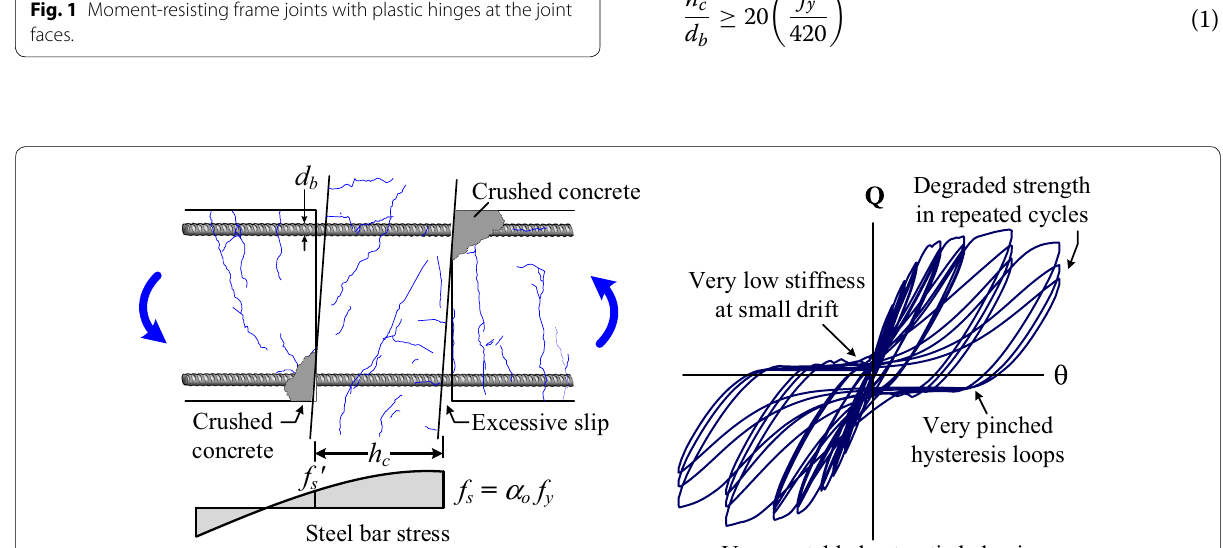
Fig. 2 Consequences of bond deterioration along the beam bars passing through a joint with Grade 420 reinforcement, 31‑MPa concrete, and 20 d b column depth (Lee et al.